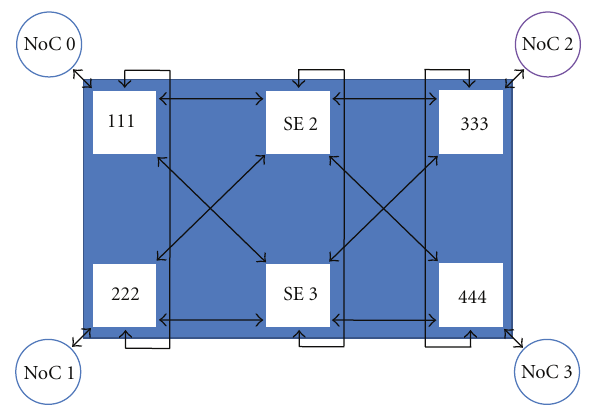
Figure 14: The simulation state of NiP-PNN model at second step of worst case.